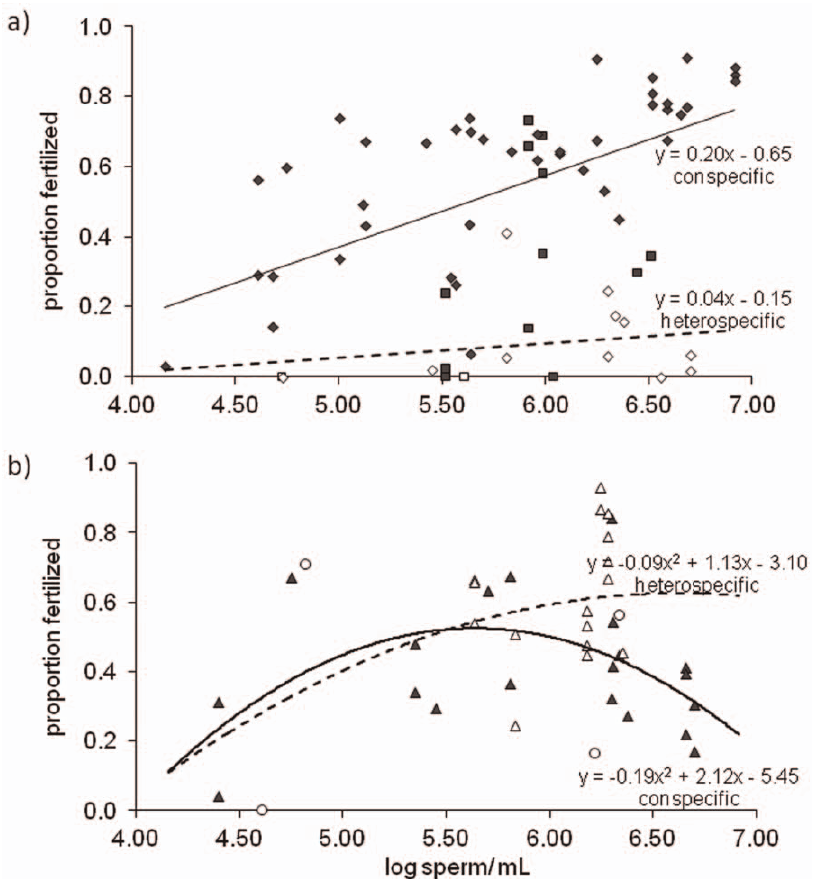
Figure 3. No-choice fertilization crosses demonstrating the proportion of eggs fertilized as a function of log sperm concentration. (A) Fertilization assays with A. palmata eggs where diamonds represent Belize crosses and squares Florida Keys crosses. (B) A. cervicornis eggs where triangles represent Belize crosses and circles represent Florida Keys crosses. Closed symbols and solid lines represent conspecific crosses and open symbols and dashed lines are heterospecific crosses.